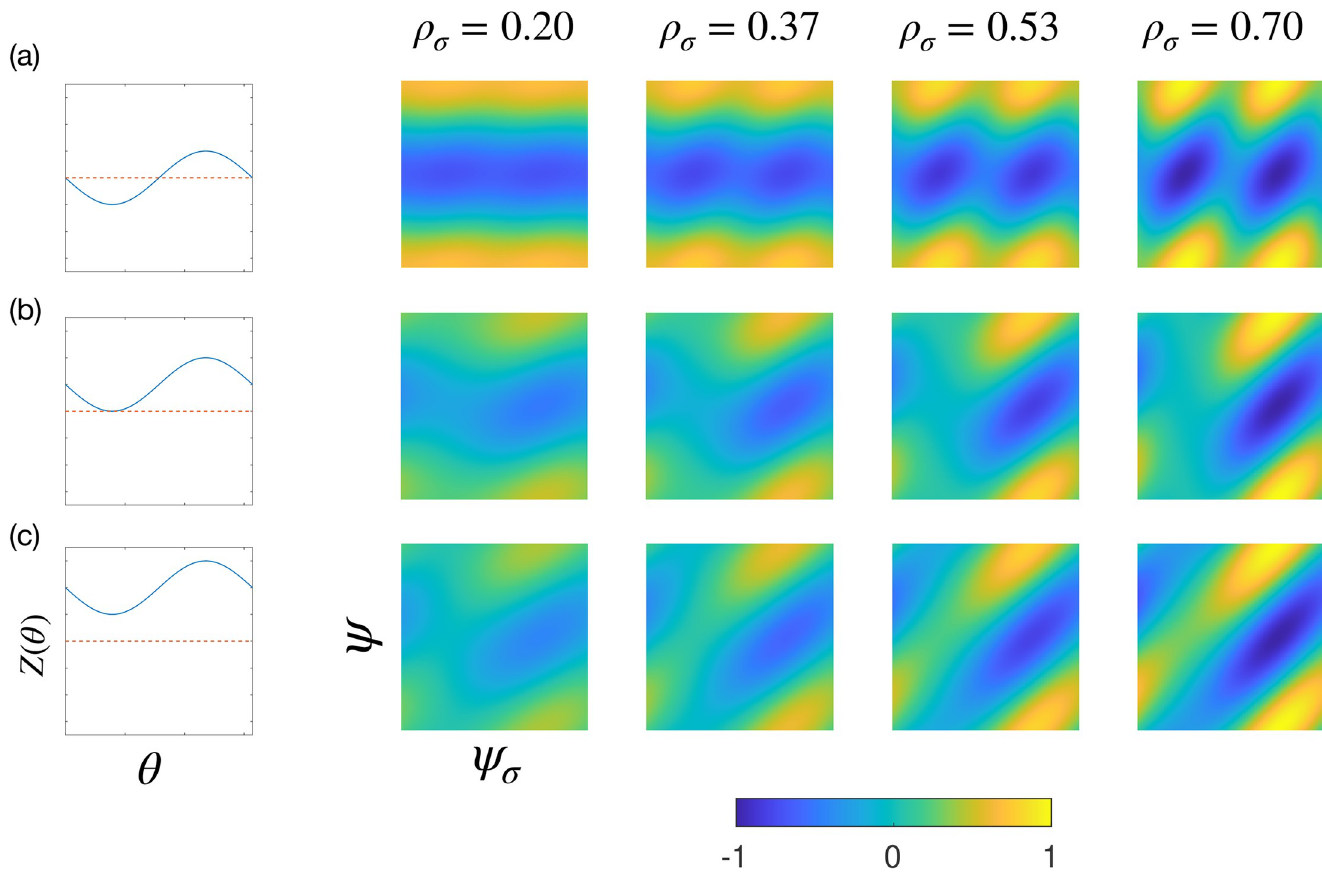
Fig 2. The local amplitude response Γ σ for different ρ σ and Z ( θ ). The panels (a), (b) and (c) are for Z ( θ ) = a 0 /2 − sin( θ ), with a 0 = 0, 2 and 4, respectively. For each plot, the vertical axis is the global phase ( ψ ) and the horizontal axis is the local (or population) phase ( ψ indicated by a red dashed line. Blue regions indicate areas where stimulation is predicted to suppress